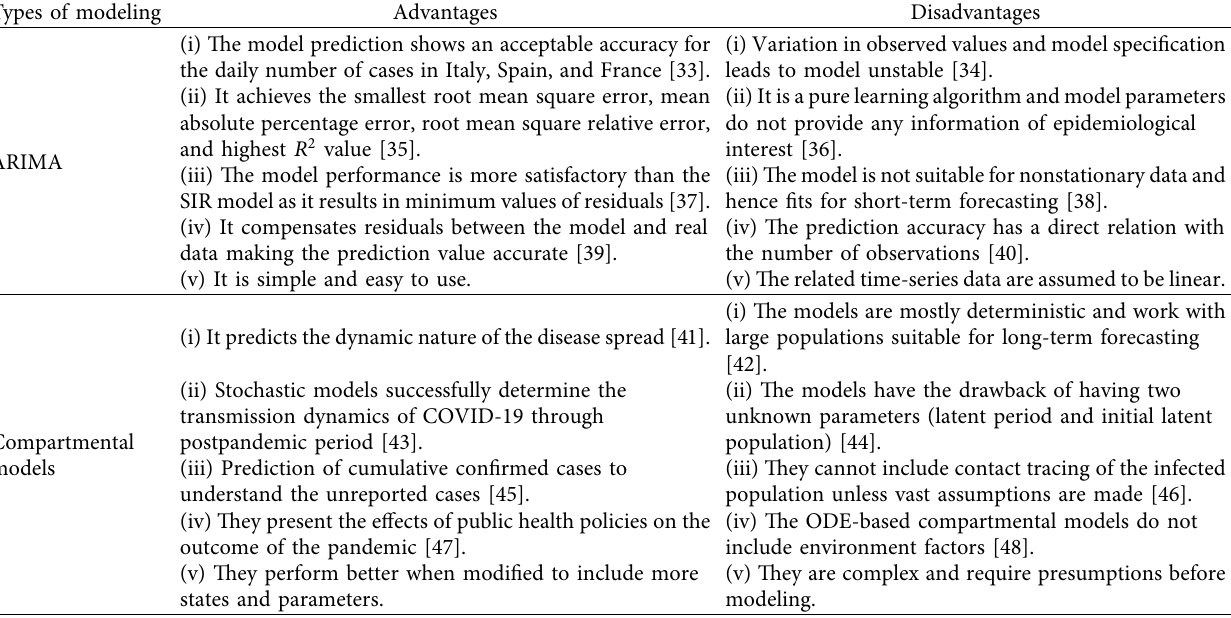
Table 1: Comparison of research works for COVID-19 disease prediction using modeling. Types of modeling Advantages Disadvantages